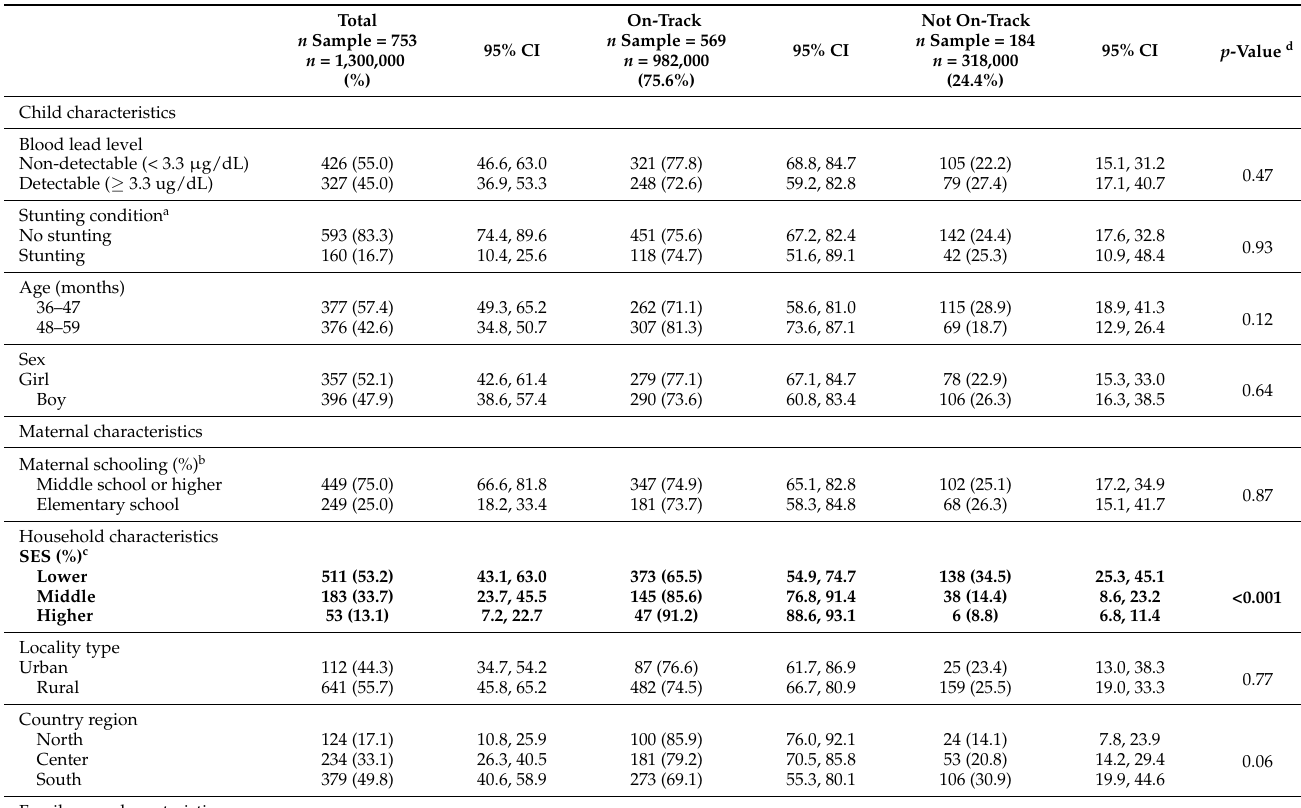
Table 2. Early Childhood Development Index (ECDI) by children, mother, household, and family care